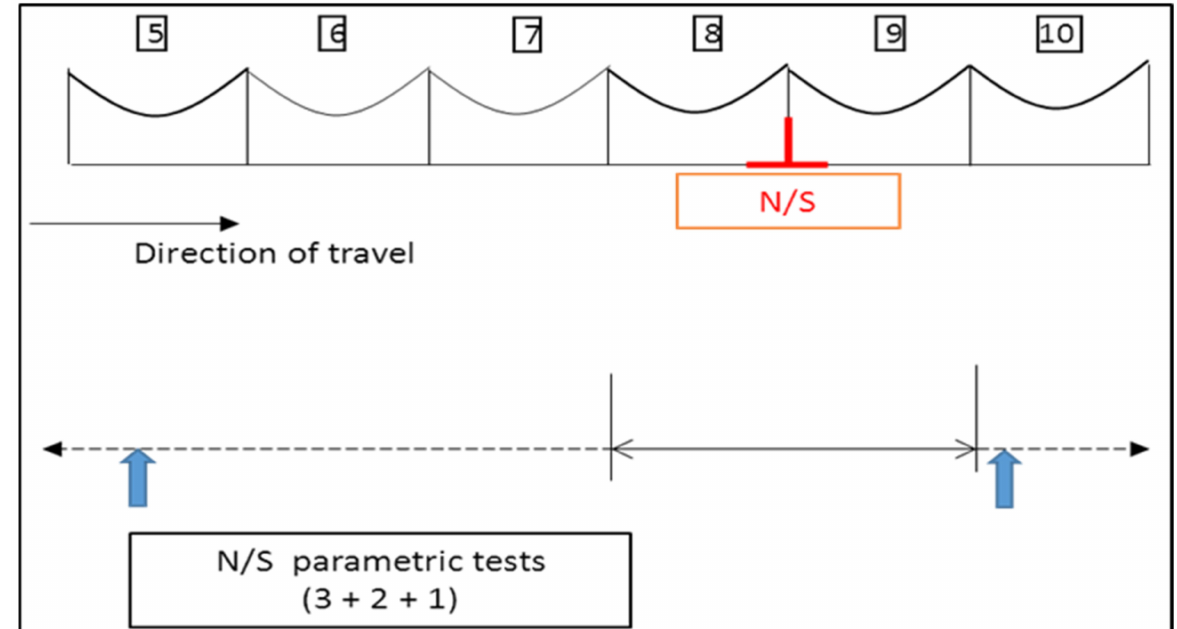
Figure 17. Model and analysis section for parametric analysis baseline, showing single pantograph start and end positions, in a 3+2+1 span